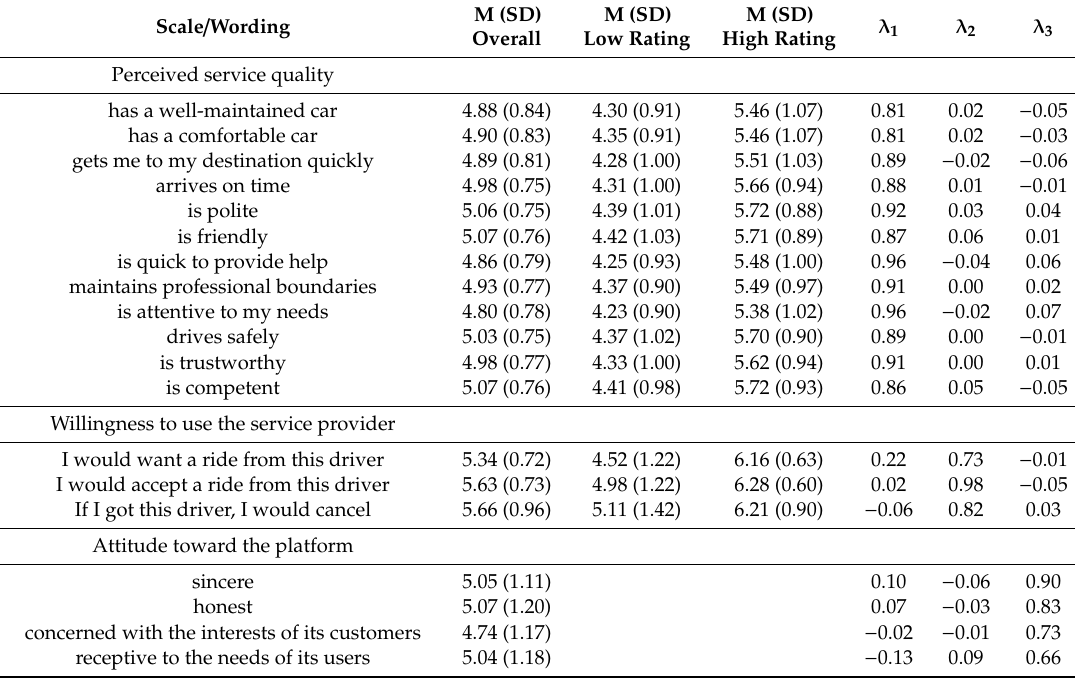
Table 1. Measurement items, descriptive statistics, and factor